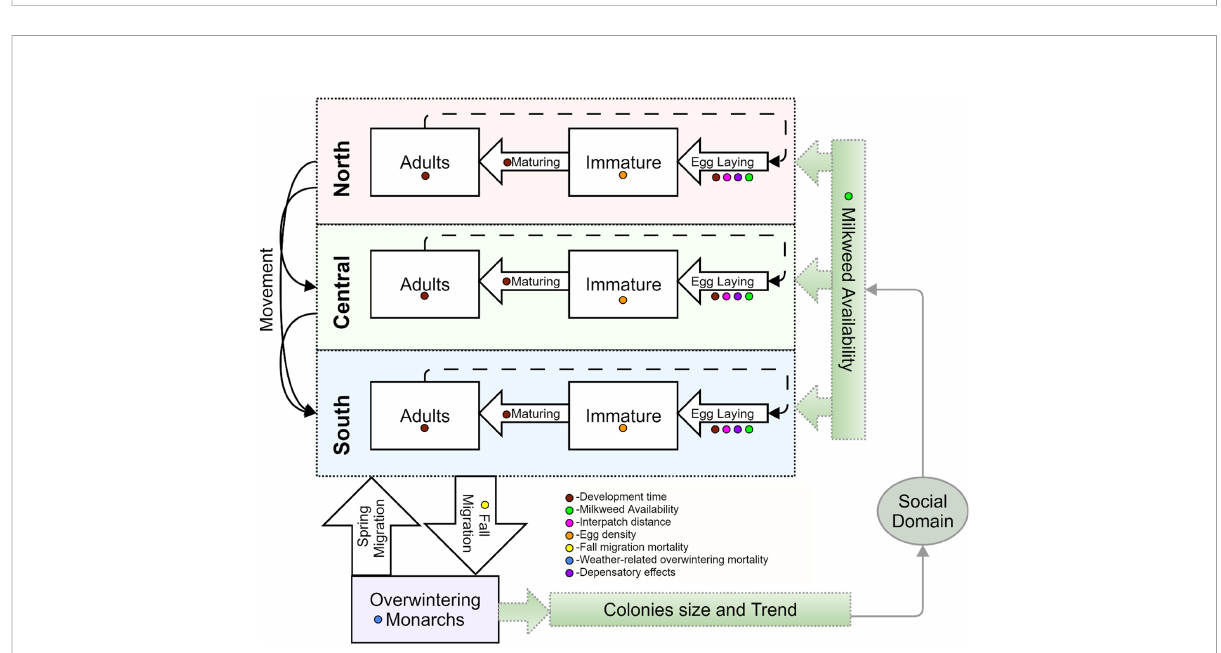
FIGURE 3 Spatial (vertical dimension) and stage-class (horizontal dimension) structure of the Monarch Butter fl y System Dynamics Model (MOBU-SDyM). Simulated Monarchs reproduce and disperse across the three breeding regions during the breeding months and mobilize to a non-breeding overwintering region during the overwintering season. The coloured dots give the key to the system drivers that affect MOBU-SDyM dynamics. In green gradient and gray outline, the lower-right part of the diagram represents where the MOBU-SDyM is coupled with the behaviour models from the social domain. Figure modi fi ed from Solis-Sosa et al.